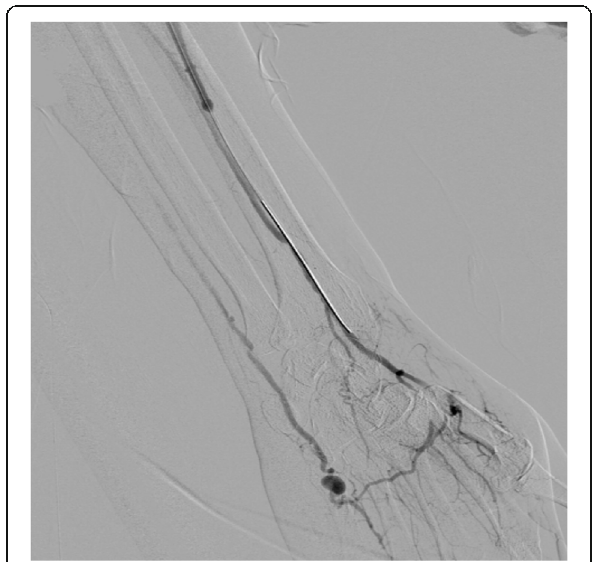
Fig. 1 Pre-embolization angiogram showing a pseudoaneurysm in the distal aspect of the radial artery at the level of the base of the